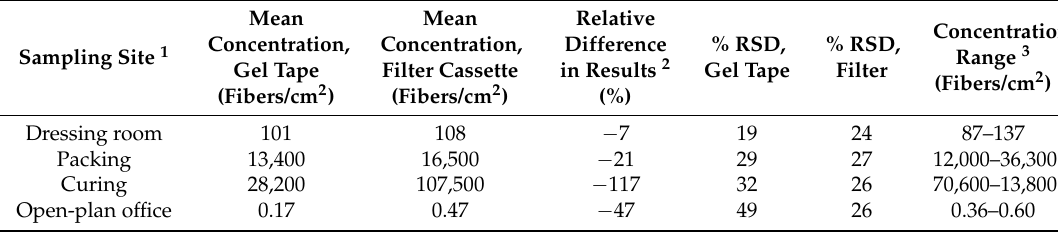
Table 1. Deviation of results between methods vs method-specific relative standard deviations in samples from production plant and open space